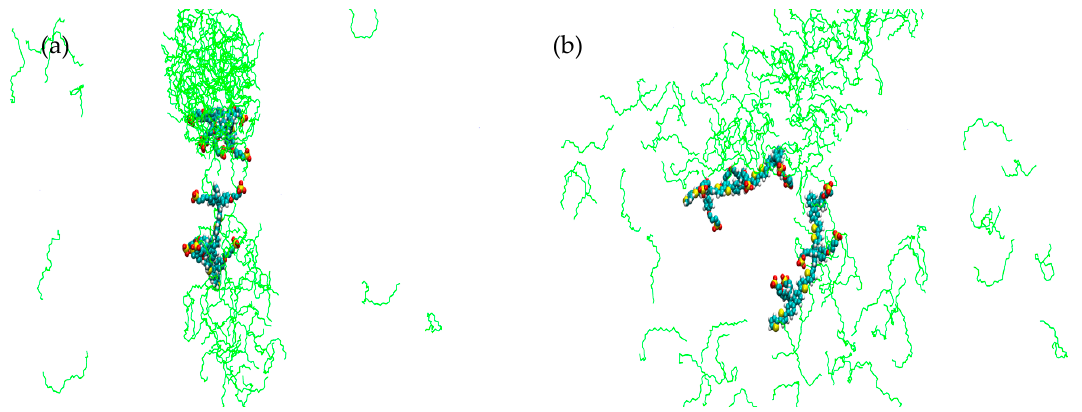
Figure 5. Simulation cell representation of ( a ) front view; and ( b ) side view of 680 mM C 12 E 5 with two equivalents of PBS-PF2T at 90 °C after 10 ns, system 6 . (PBS-PF2T is shown in van der Waals representations and solvent is omitted for clarity).